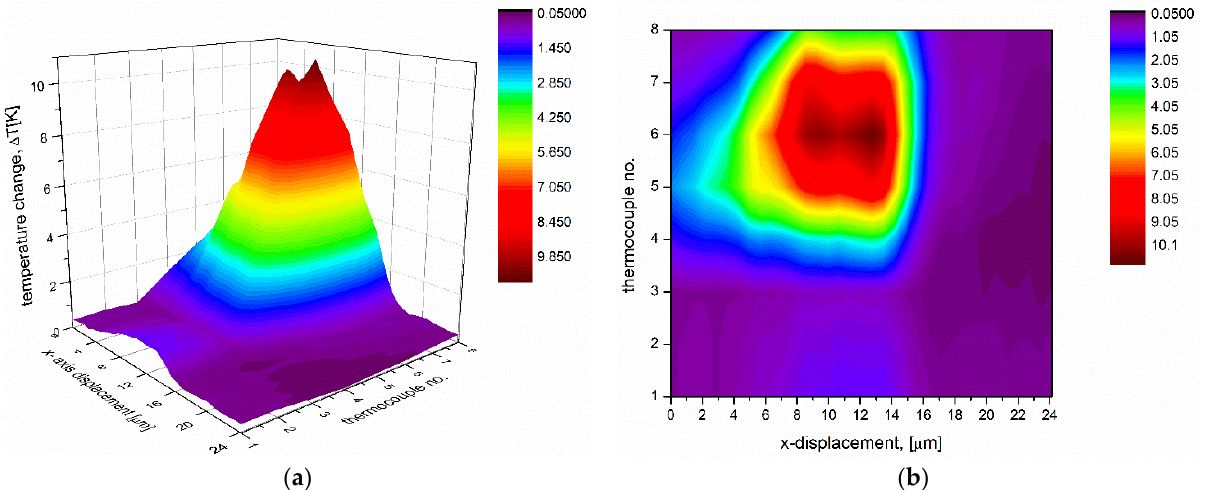
Figure 6. Two graphs plotted by the calculated values of the temperature increase based on the measurements performed by each thermocouple 1 to 8 (shown in Figure 3b) at the same time; ( a ) the 3D graph relates to the Gaussian profile of the incident beam; ( b ) the 2D graph depicts temperature distribution in the illuminated area.